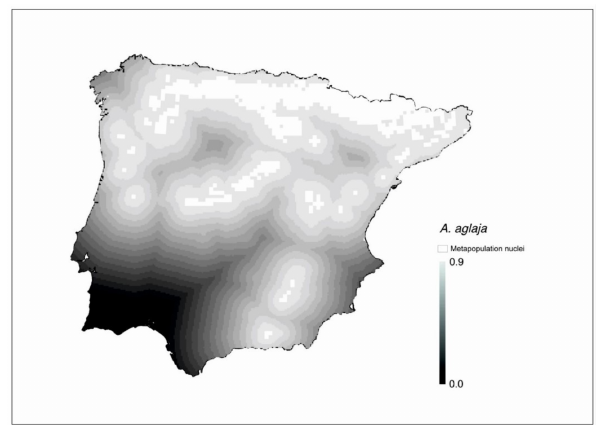
Figure 5. Connectivity gradient between metapopulation nuclei (white plots) of Argynnis aglaja . The matrix has been graded on a scale of eighteen levels of connectivity with a 0.05 connectivity range each (represented in